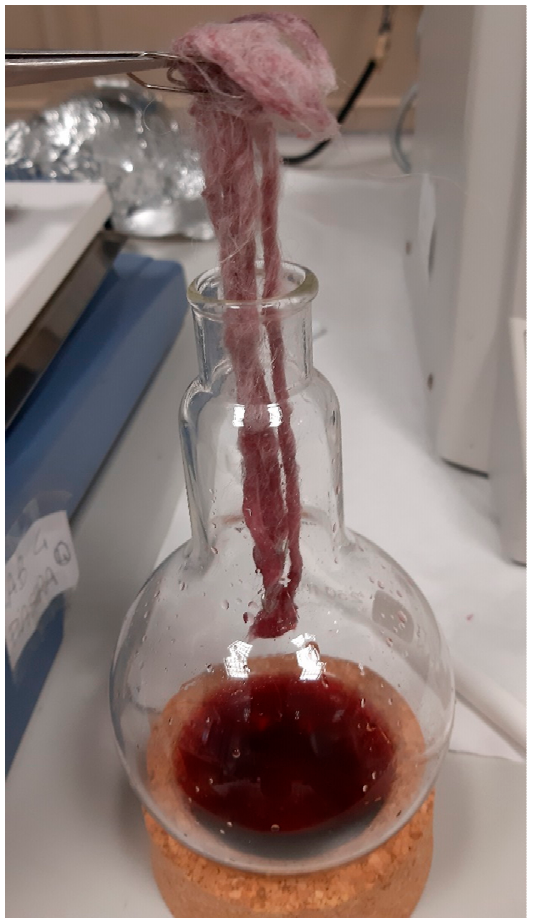
Figure 3. Image of the samples immersed in an aquatic extract of Opuntia ficus-indica (L.) Miller .